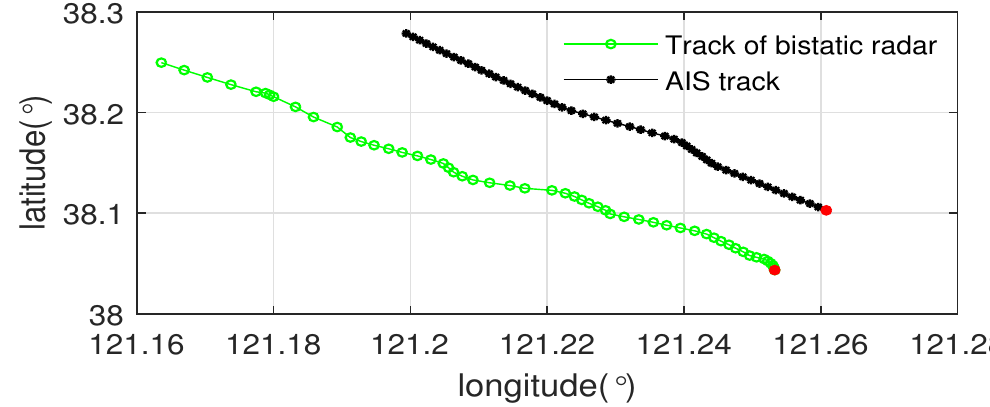
Figure 11. Track comparison between bistatic radar and AIS of target